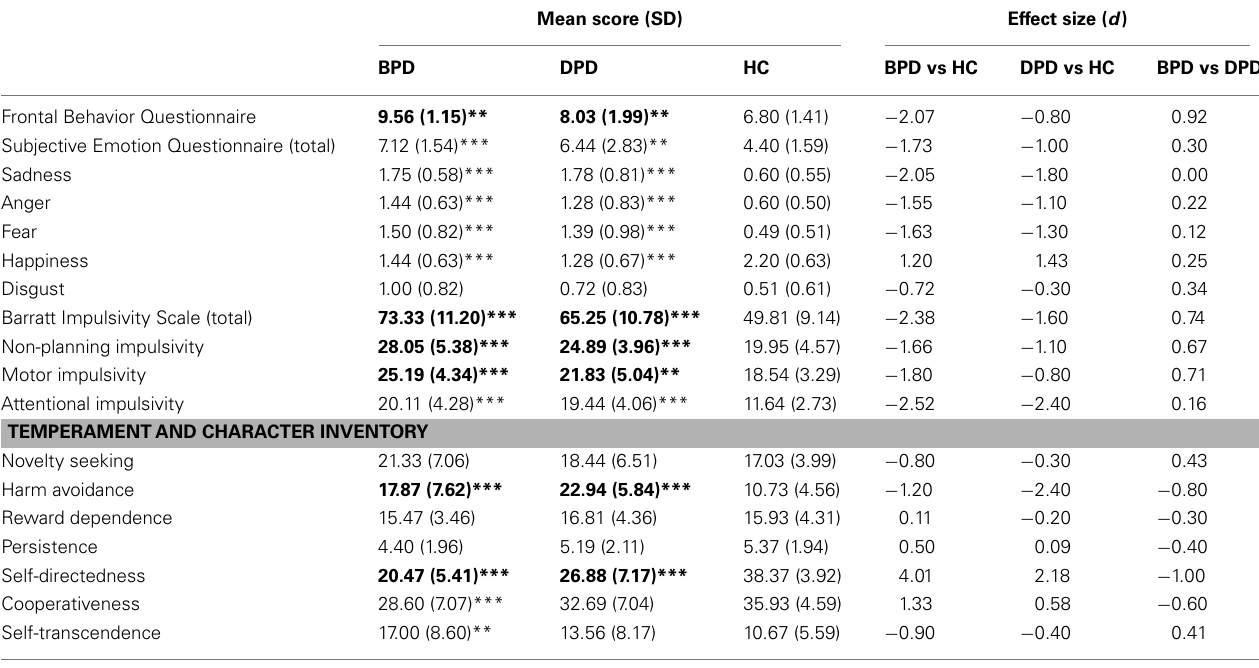
Table 3 | Means, SDs, and effect sizes for each self-report questionnaire, by